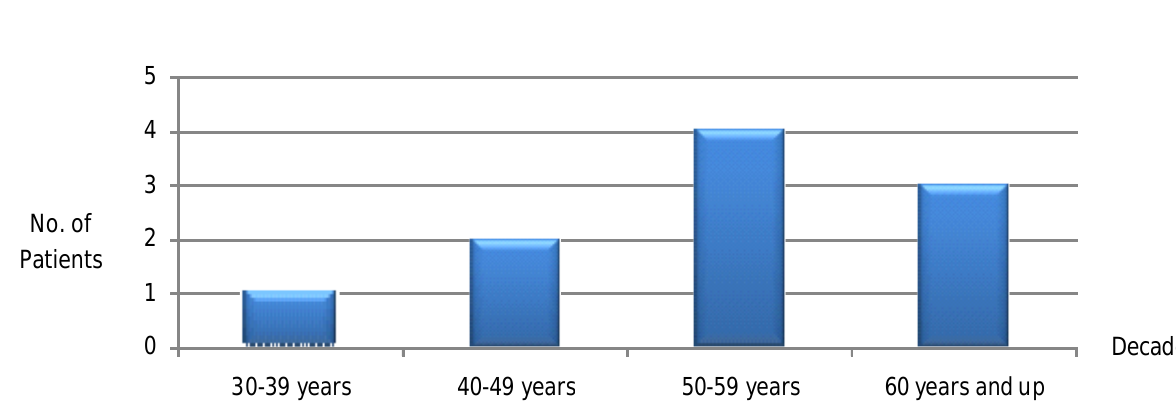
Figure 3: Malignant group